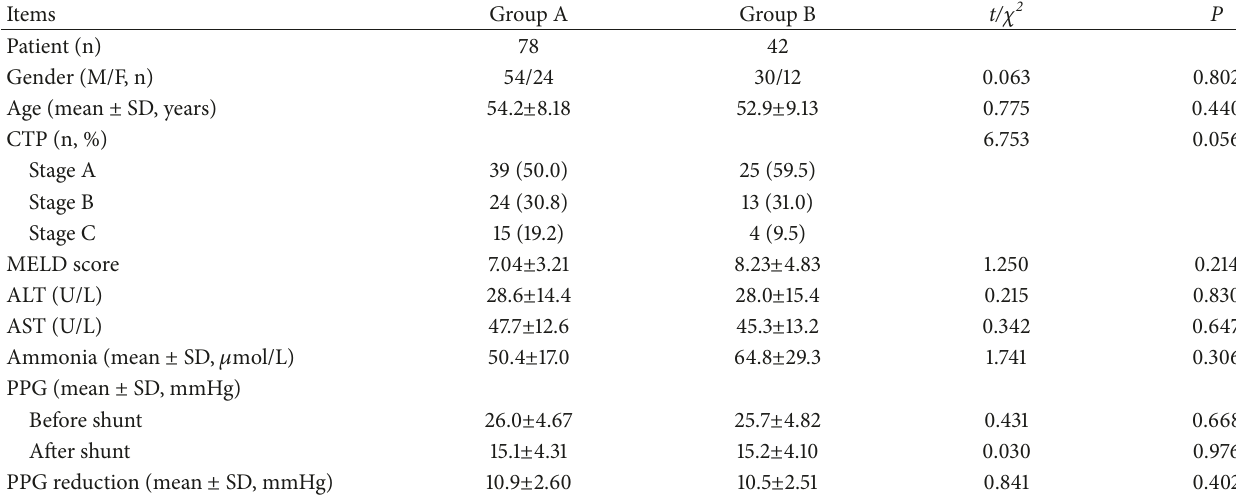
Table 1: Perioperative clinical characteristics of two groups.